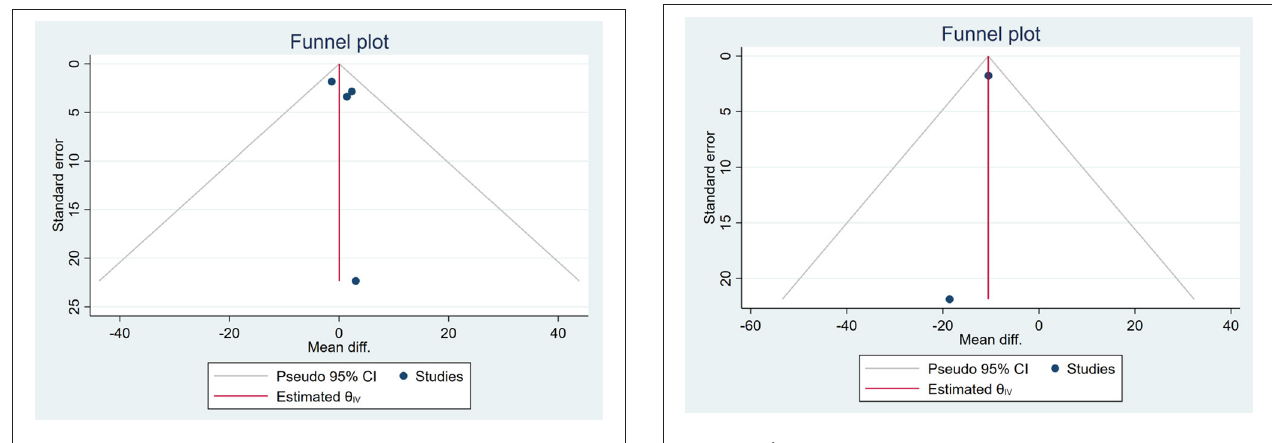
FIGURE 23 | Funnel plots of the effect of ALT.